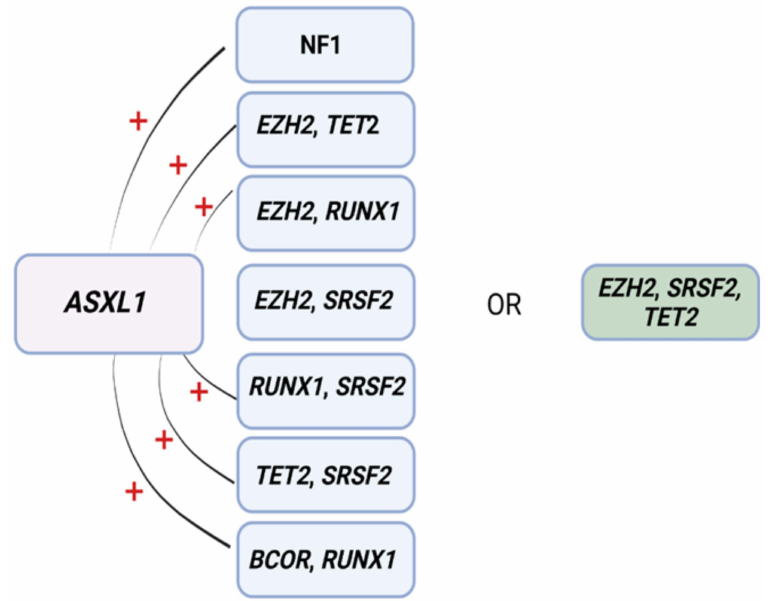
Figure 3. Mutational patterns conferring resistance to hypomethylating agents. Associations among genes identified to induce resistance to hypomethylating drugs. Abbreviations: ASXL1, ASXL transcriptional regulator; NF1, neurofibromin 1, EZH2, enhancer of Zeste 2 polycomb repressive complex 2 subunit; TET2, ten-eleven translocation 2; RUNX1, RUNX family transcription factor 1; SRSF2, serine and arginine rich splicing factor 2; BCOR, BCL6 corepressor. Modified from Nazha et al. [72]. BioRender was used to make the